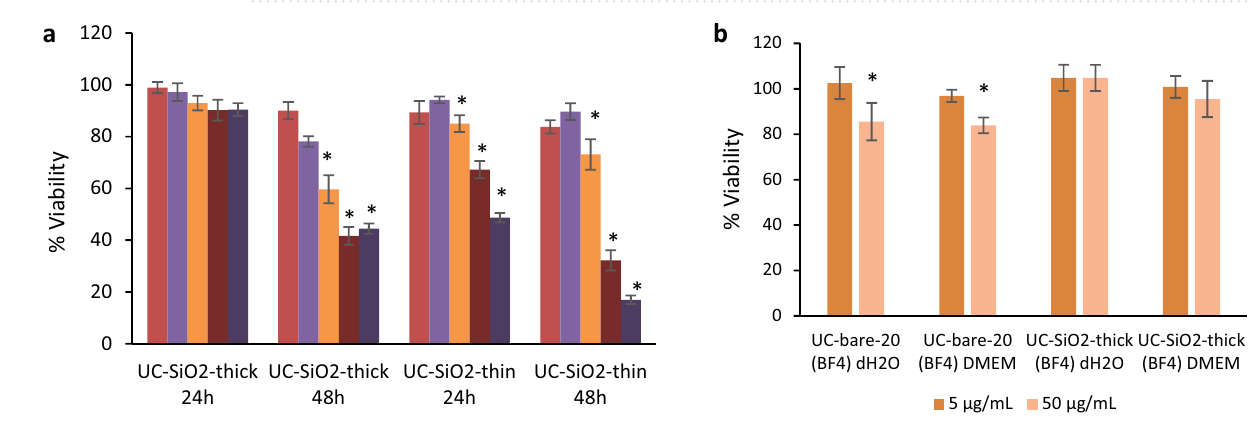
Figure 6. Viability of HaCaT cells exposed to ( a ) UC-SiO 2 -thick and UC-SiO 2 -thin for 24 h and 48 h; and ( b ) UC-bare-20 (BF 4 ) and UC-SiO 2 -thick after 72 h of aging in di-H 2 O and DMEM. The results are reported as mean ± standard deviation (SD) of 4 technical replicates in each of the 3 independent experiments for 24 h and 48 h. The differences were considered statistically significant from p < 0.05: * indicates significant differences compared to the